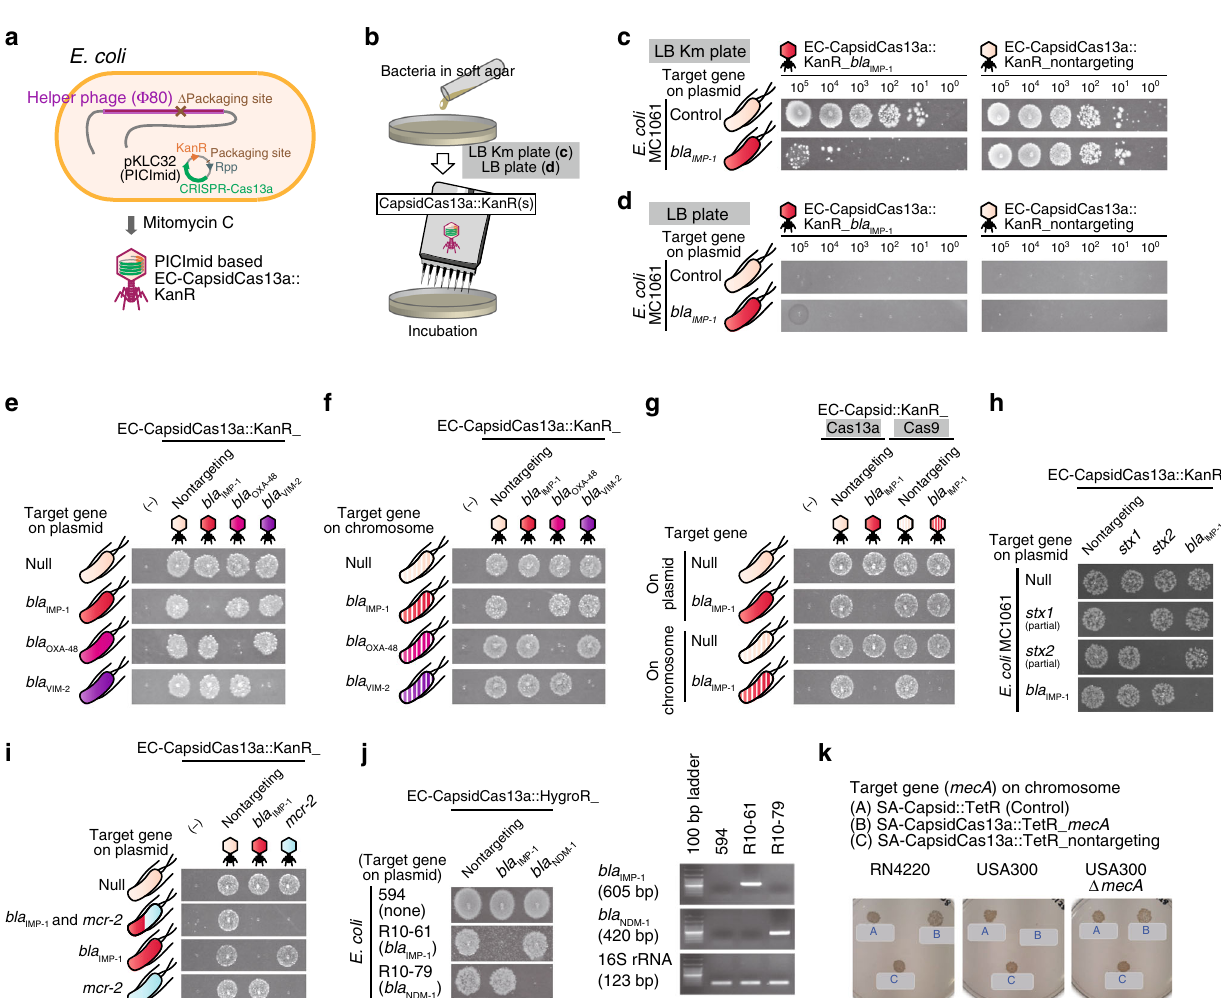
Next, we tested the detection ef fi ciency of the constructs for bla IMP-1 by spotting 2 µL of tenfold serial dilutions of EC- CapsidCas13a::KanR_ bla IMP-1 and EC-CapsidCas13a::KanR_- nontargeting onto fresh top agar lawns of the test strains in Luria-Bertani (LB) agar with or without supplementation of Km (Fig. 5b). To improve the ef fi ciency, we opted to determine the bacterial killing effect against Km-resistant cells on Km plates (Fig. 5c), rather than assessing the bacterial killing effect against original cells on Km-free plates (Fig. 5d). When the EC- CapsidCas13a::KanR_ bla IMP-1 carrying the Km resistance gene was applied on the soft agar bacterial lawn grown on bottom agar containing Km, the cells infected by this capsid acquired Km